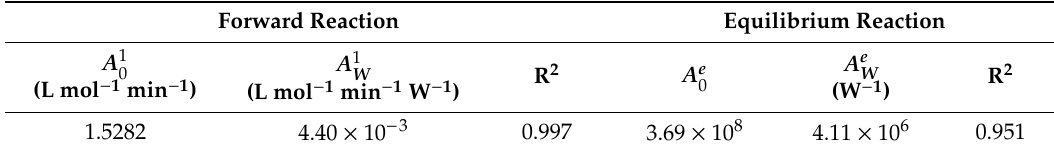
Table 3. Constants and power coe ffi cients for describing the relationship between microwave power and pre-exponential